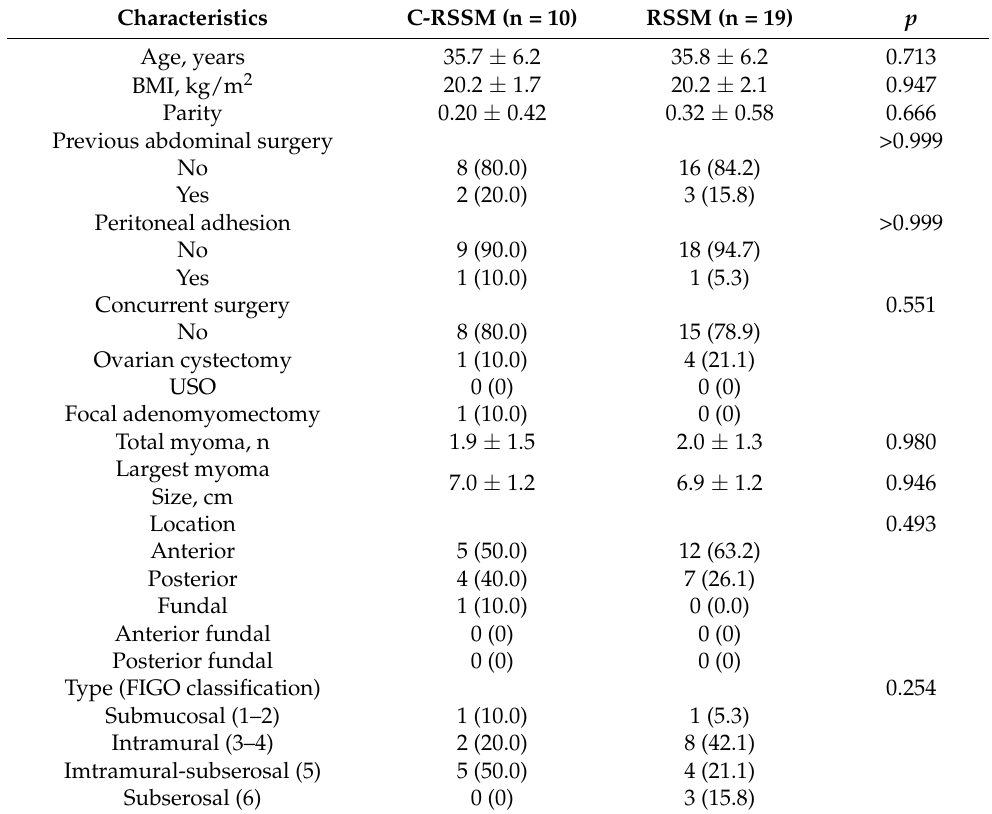
Table 2. Baseline characteristics of myomectomy patients after propensity score matching